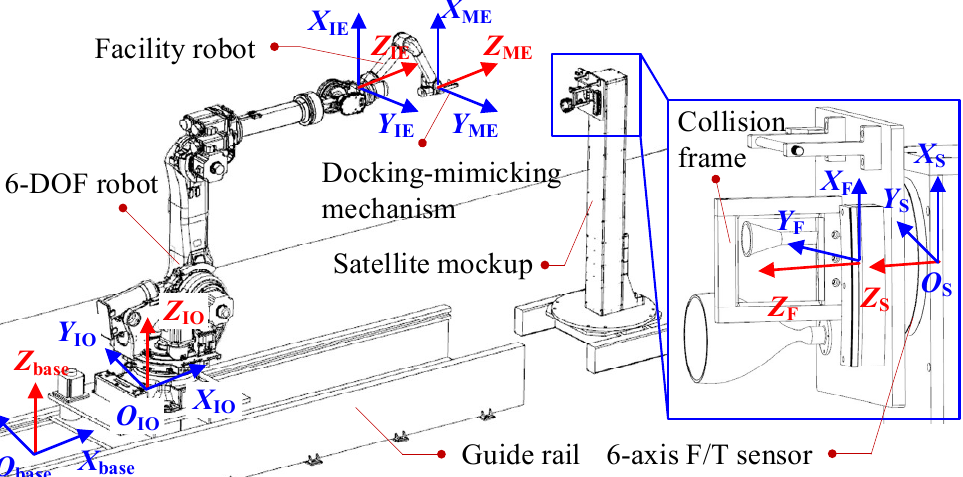
Figure 4. Coordinate systems of the HIL simulator.